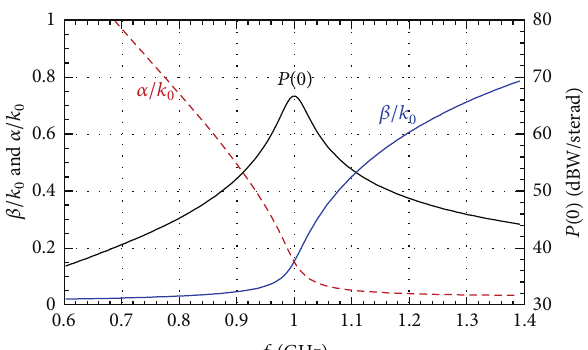
Figure 7: Same as in Figure 5 for a structure with 𝑏 = 𝜆 0 /300 at 𝑓 = 1 GHz. Other parameters: 𝐵 𝑓 = 47.75 .